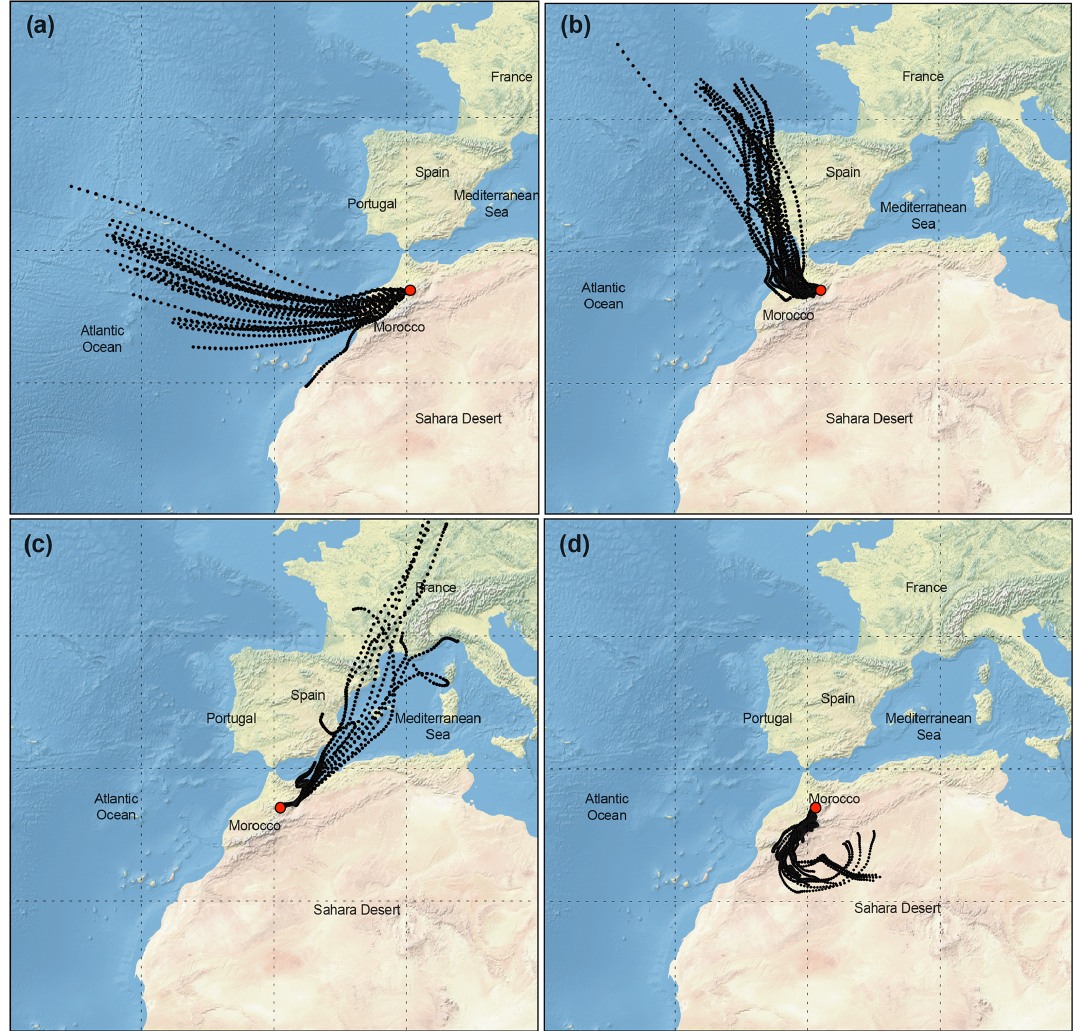
Figure 4. Typical 96h air mass back trajectory performed for AMV during routine sample periods; aerosol type and PM 10 mass concentration are given in parentheses. (a) 18 December 2017: air mass from the North Atlantic Ocean considered to be representative of background conditions (BAM, m = 10 . 9µgm − 3 ). (b) 10 October 2017: air mass from Europe crossing the coastline of northern Morocco (Atlantic coast Europe, m = 44 . 1µgm − 3 ). (c) 2 November 2017: slightly polluted air mass from the northeast crossing Mediterranean Sea Morocco (Mediterranean coast Europe, m = 26 . 4µgm − 3 ). (d) 13 August 2017: dust-loaded air mass coming from the Sahara (Saharan dust, m = 94 . 1µgm − 3